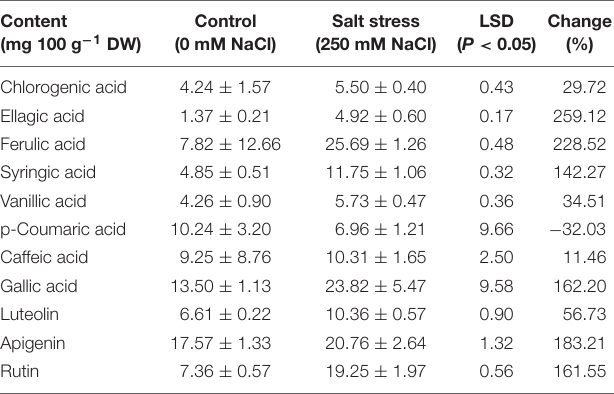
TABLE 4 | Means ( ± SE) of phenolic acids and flavonoid contents of the leaves of the studied genotypes under control and salt stress